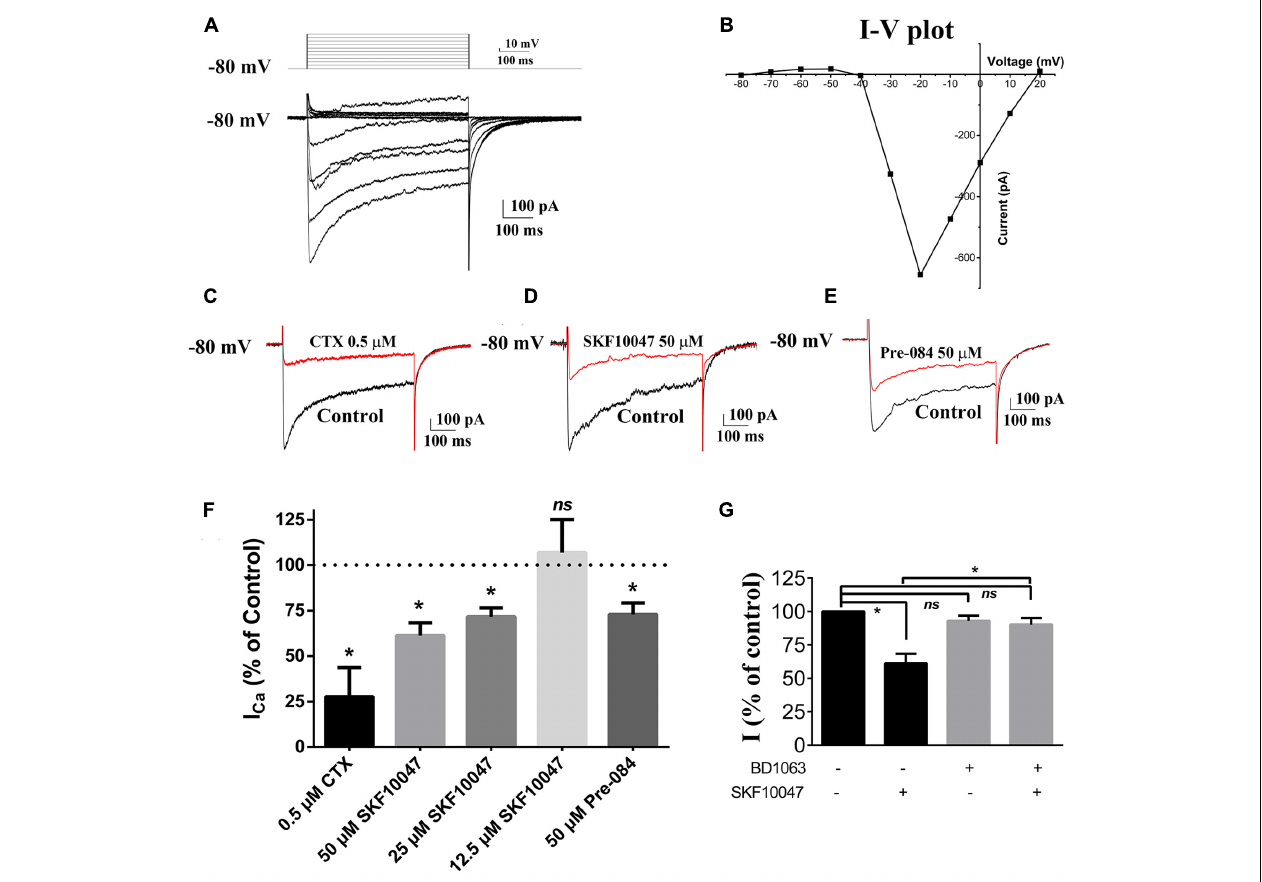
FIGURE 2 | Sigma-1 receptor agonist reduced currents of Ca 2 + channel in ChIs. (A) Representative trace of Ca 2 + channel current obtained from the rat striatum ChIs in the brain slice. (B) I–V plot of the recorded Ca 2 + channel current trace in (A) . (C–E) Representative traces of current evoked before and after the bath application of 0.5 µ M CTX, 50 µ M SKF-10047, and 50 µ M Pre-084, respectively. (F) Summarized bar graph to present the effect of CTX (N-type Ca 2 + channel blocker), different concentrations of SKF-10047 and Pre-084 (sigma-1 receptor agonists) on Ca 2 + currents. (G) Summarized bar graph to present the effect of BD-1063 (sigma-1 receptor antagonist) on the Ca 2 + current inhibition induced by SKF-10047. ∗ p < 0.05.